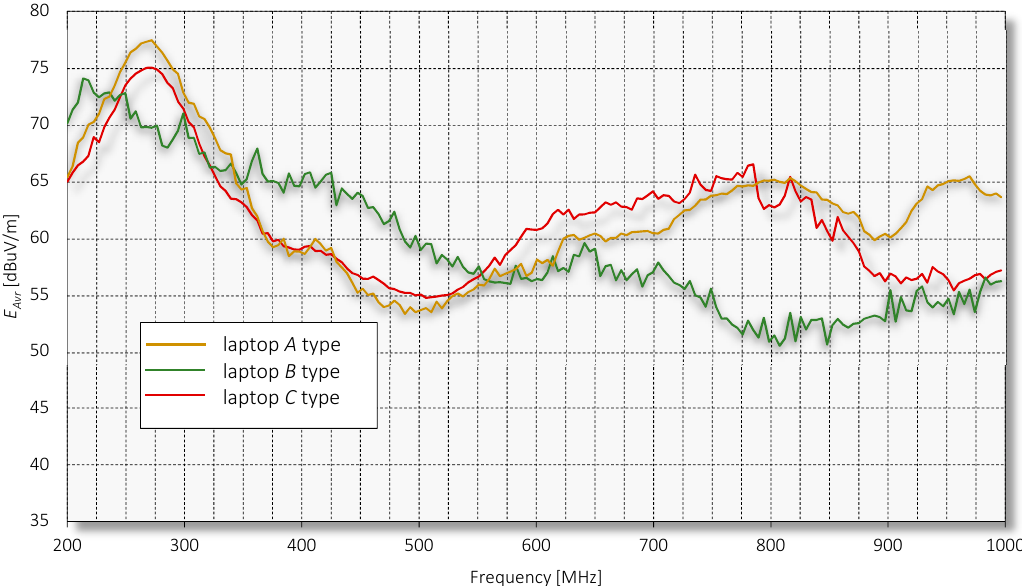
Figure 12. Average values of EM disturbances (valuable emissions) for three measured laptops in the range of frequencies from 200 MHz to 1 GHz.